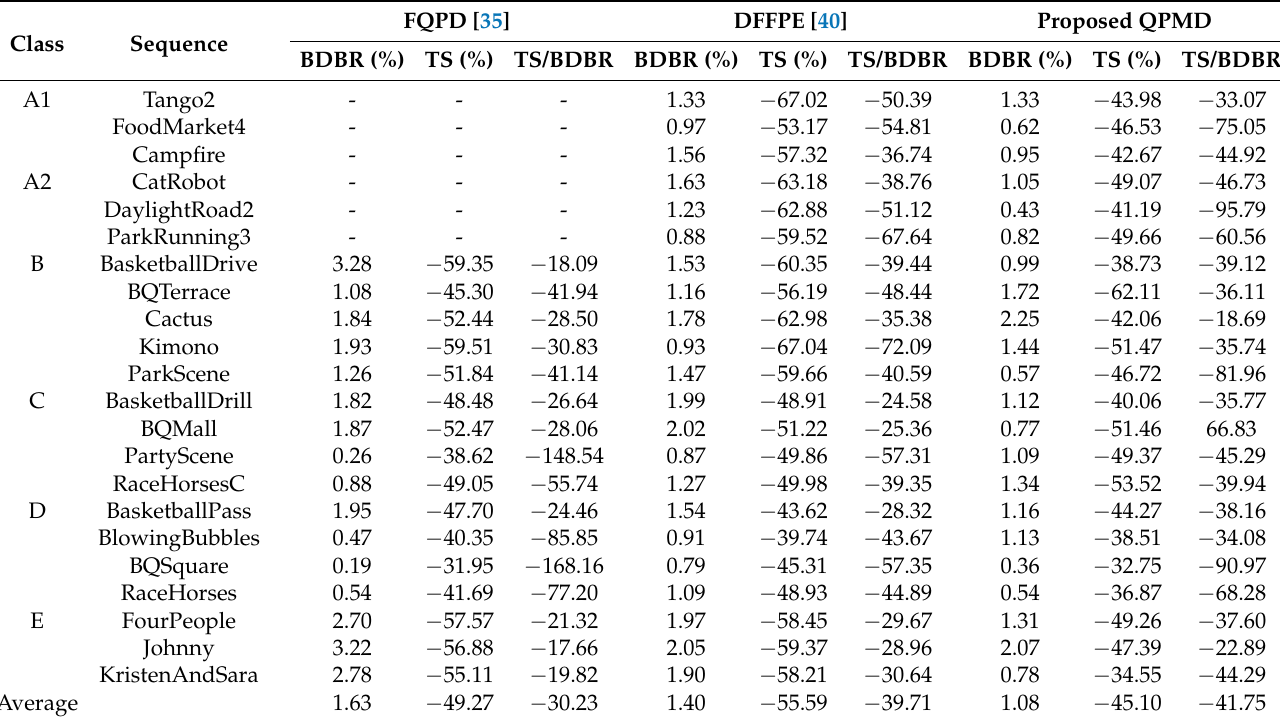
Table 2. Coding performance of the proposed QPMD algorithm compared to DFFPE and